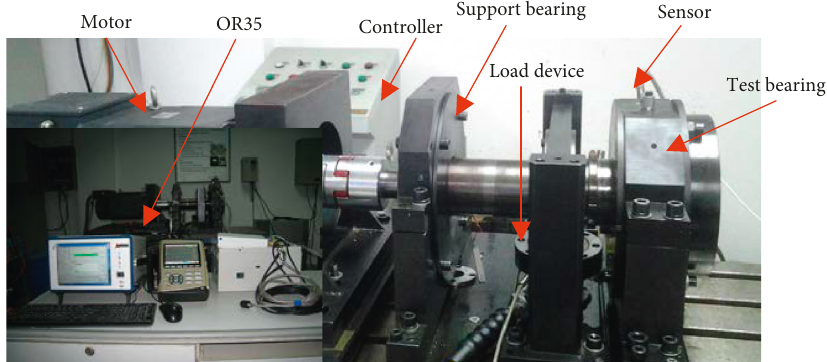
Figure 10: The test rig for bearing dynamic quality inspection.